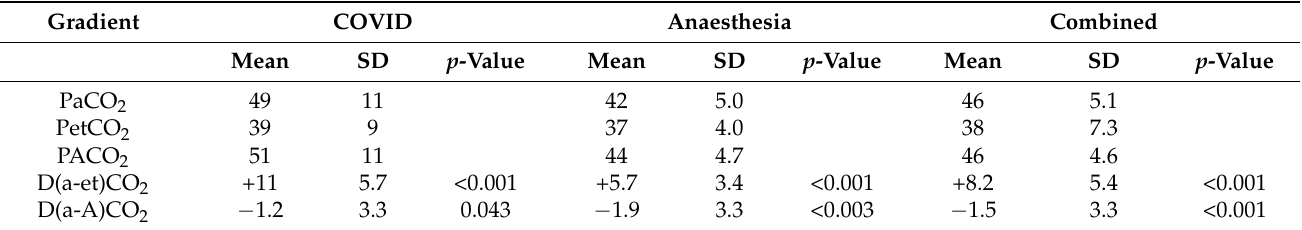
Table 2. Mean PCO 2 (mm Hg), and Student’s t-test for comparison of paired values in the COVID group, the anaesthesia group, and the combined groups.